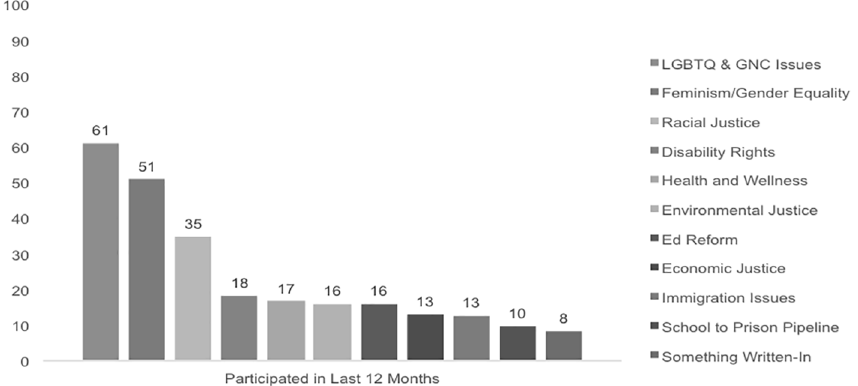
Figure 3. LGBTQGE youth involvement in social